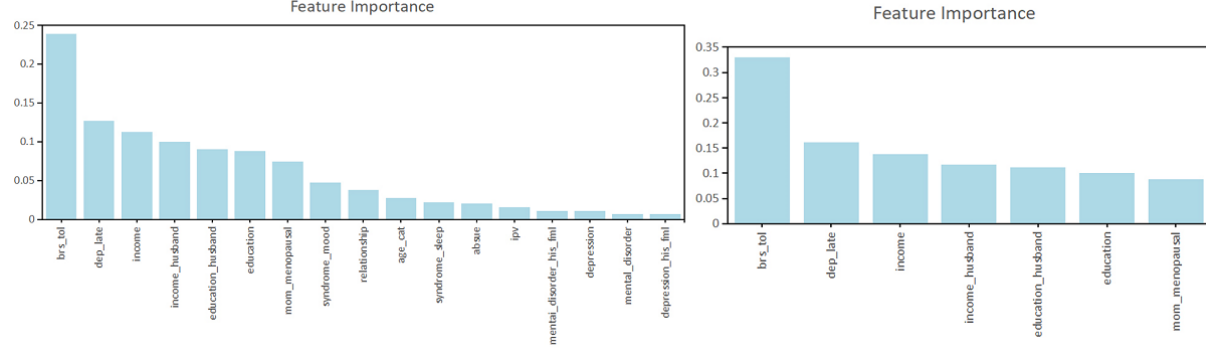
Figure 6. The relative feature importance rankings of the E-RF and the F-RF based on the two feature selection